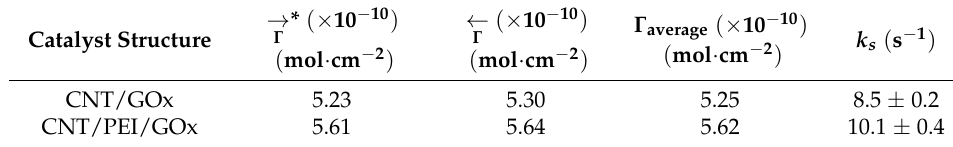
Table 1. Surface coverage activity and electron transfer rate constants of CNT/GOx and CNT/PEI/GOx at day-0.